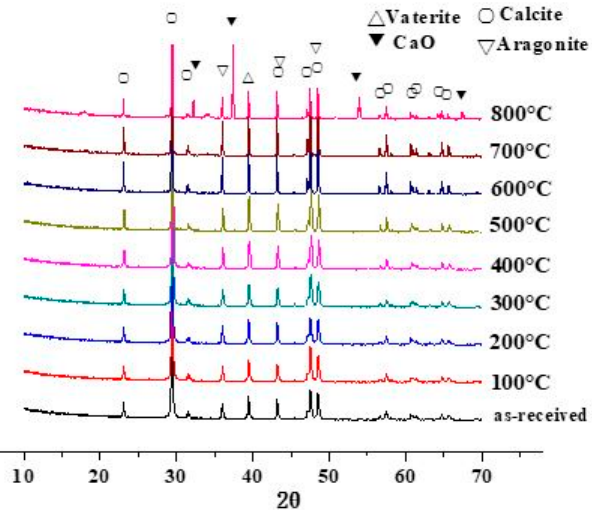
Figure 3. XRD patterns of shell powder calcined at different temperatures.